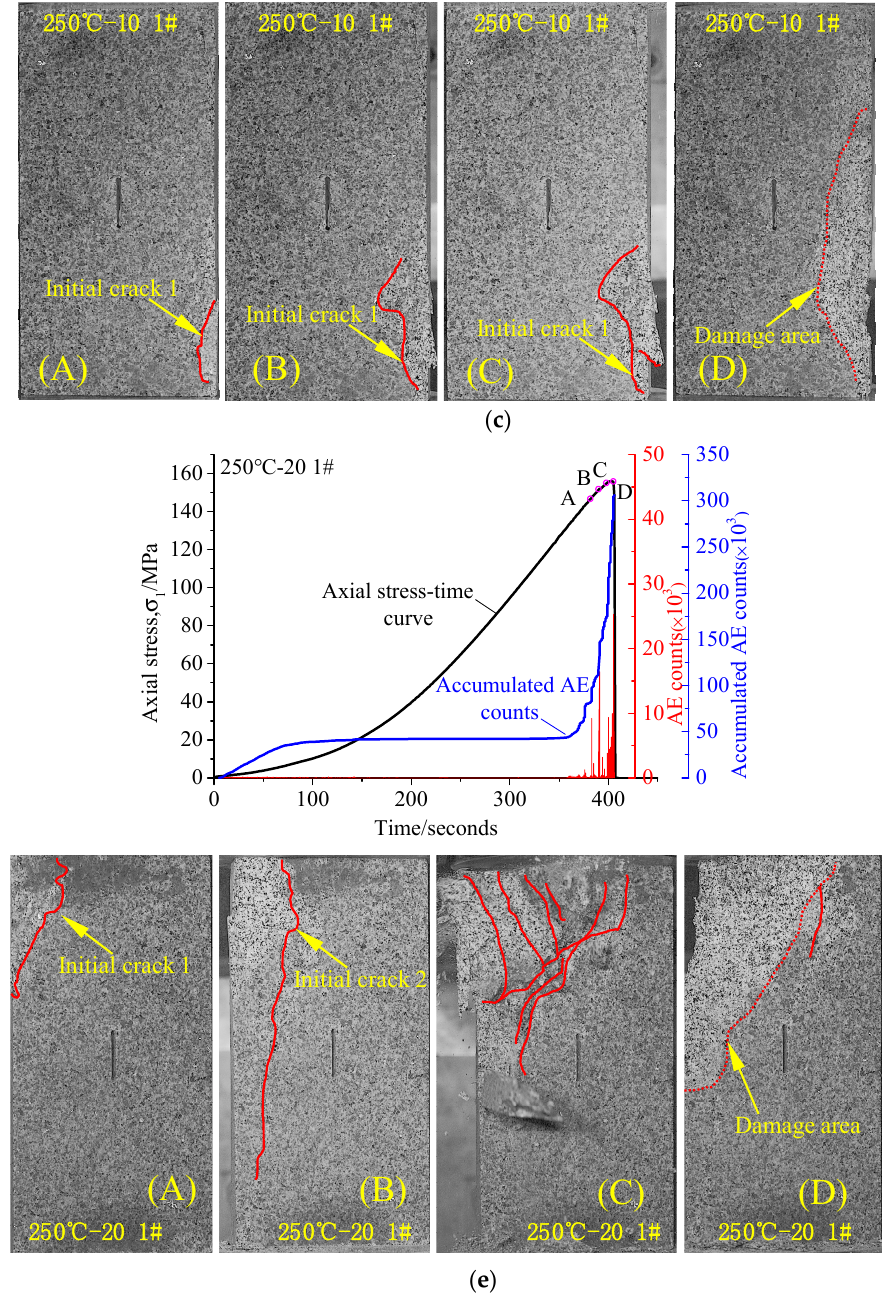
Figure 11. Specimen rupture evolution characteristics. ( a ) 250 °C-1. ( b ) 250 °C-5. ( c ) 250 °C-10. ( d ) 250 °C-15. ( e ) 250 °C-20. Table 2. Mechanical parameters of fracture characteristic points of granite with fractures. Samples